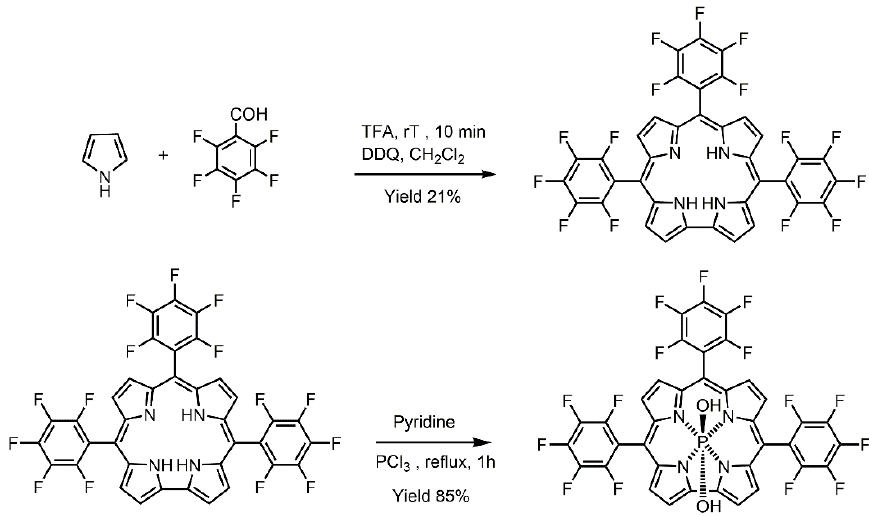
Figure 2. The schematic representation of two-step PFCorr synthesis.